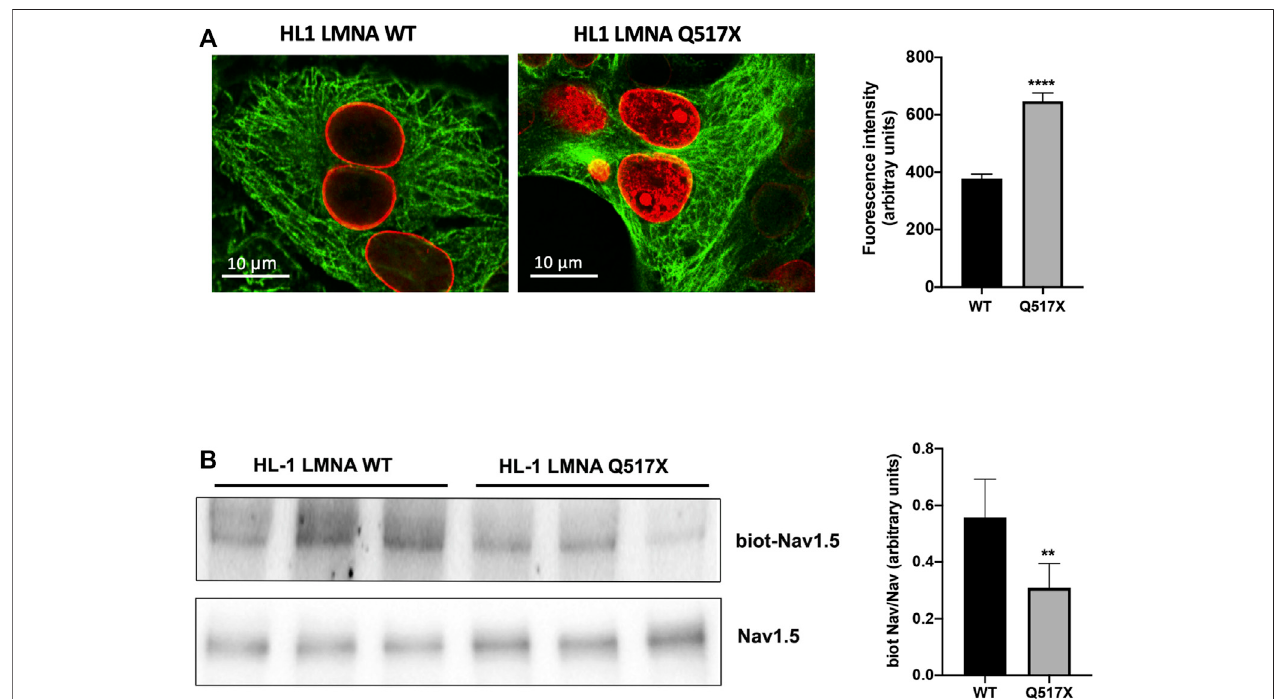
FIGURE4|(A) Leftpanel:representativeconfocallaserimmuno fl uorescenceimagesinLMNAWTandLMNAQ517X-expressingHL-1cells(inredLMNA,ingreen β -tubulin); right panel: region of interest (ROI) for tubulin fl uorescence quanti fi cation in LMNA WT and Q517X-expressing HL-1 cells. N = 15 for each experimental condition. (B) Left panel: representative western blots of Nav1.5 α subunit in cell surface biotinylated proteins (biot-Nav1.5) and in cell lysates (Nav1.5) from LMNA WT andQ517X-expressingHL-1cells;rightpanel:normalizeddensitometricanalysisofbiot-Nav1.5immunoreactivebandsinLMNAWTandQ517X-expressingHL-1 cells. The data are means of 3 independent experiments. **** p < 0.0001; ** p < 0.01; Student ’ s t test for unpaired